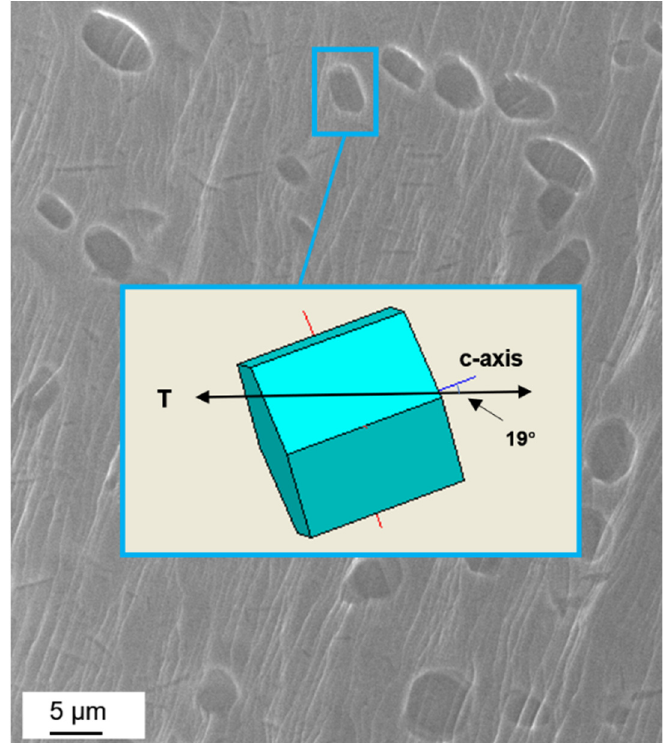
Figure 11. The crystallographic orientation of #10 α 2 grain.